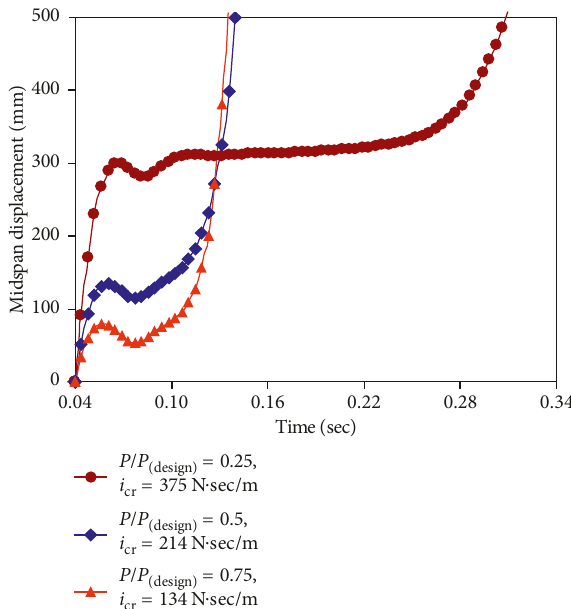
Figure 12: Midspan displacement time histories of the propped cantilever column W150